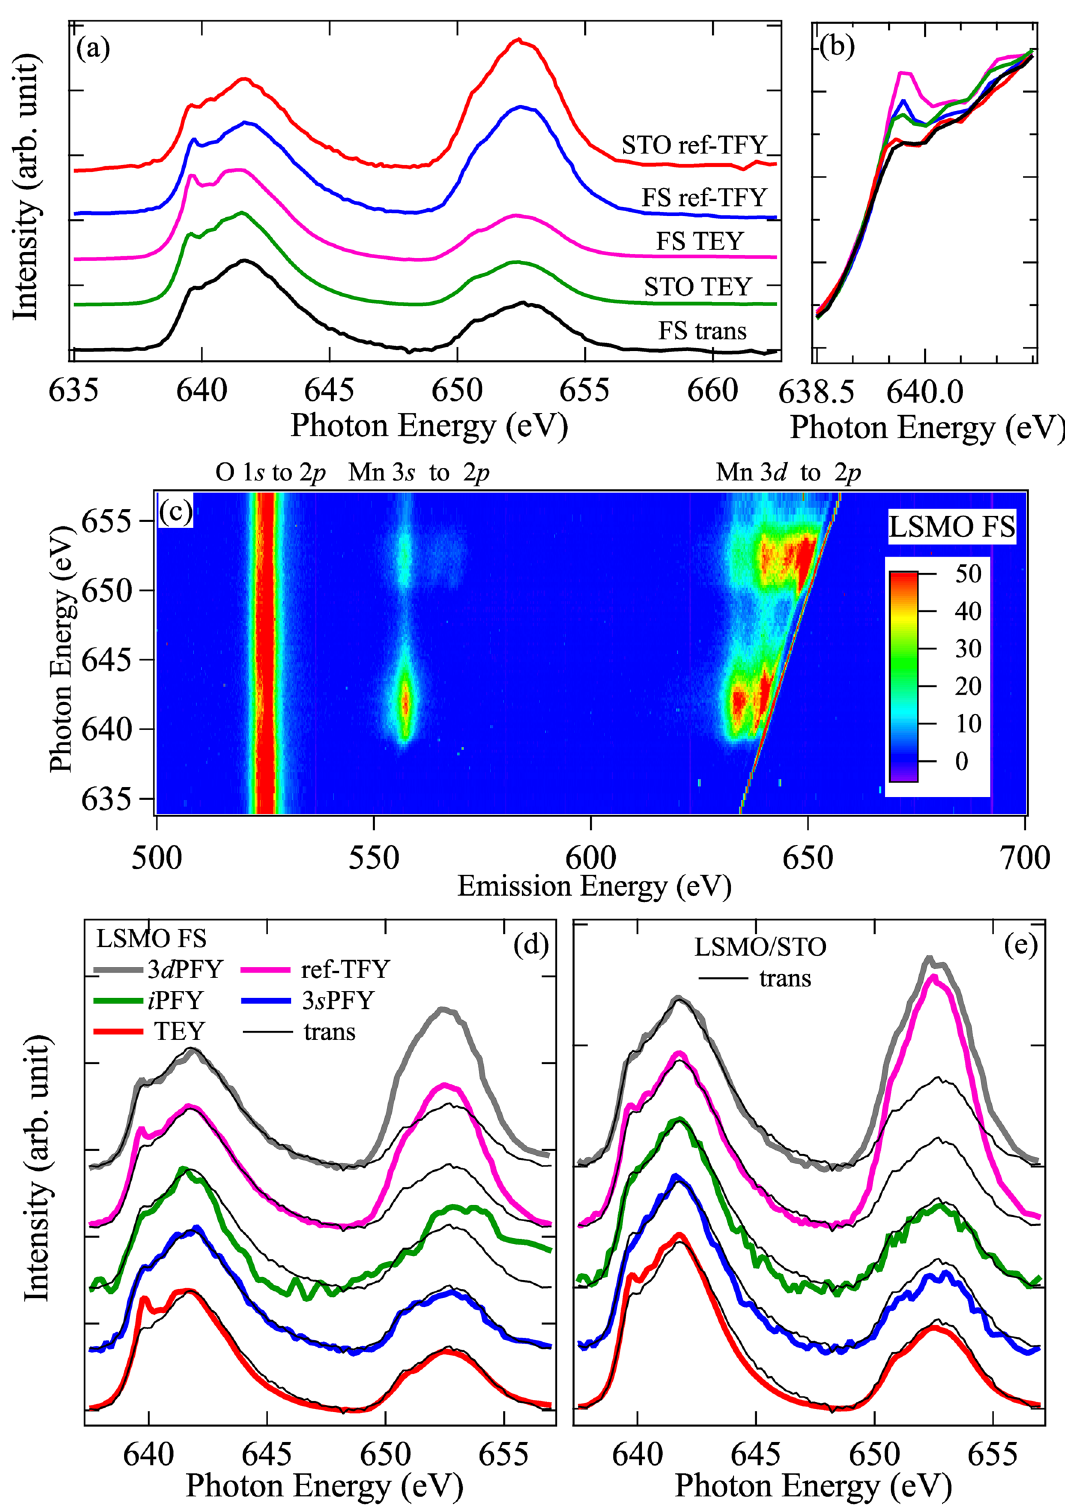
Figure 3. ( a ) Mn L 2,3 -edge x-ray absorption spectra (XAS) of LSMO thin film in freestanding form (FS) and on the STO substrate (STO) measured in TEY and TFY modes. For the FS sample, the measurements were carried out in both reflection (ref) and transmission (trans) geometry. ( b ) A magnified view of low energy shoulder around the L 3 -edge. ( c ) 2D RIXS map of LSMO-FS with incident photon energy scanned across Mn L 2,3 -edge. Features associated with different emission channels are labeled on top of the figure. ( d , e ) Comparison of TEY (red), TFY (in reflection geometry, pink), partial (3 s PFY, blue; 3 d PFY, gray)/inverse-partial yield spectra ( i PFY, green) from the RIXS maps, and the transmission XAS spectrum (thin black) from LSMO-FS for ( d ) LSMO-FS and ( e ) LSMO/STO